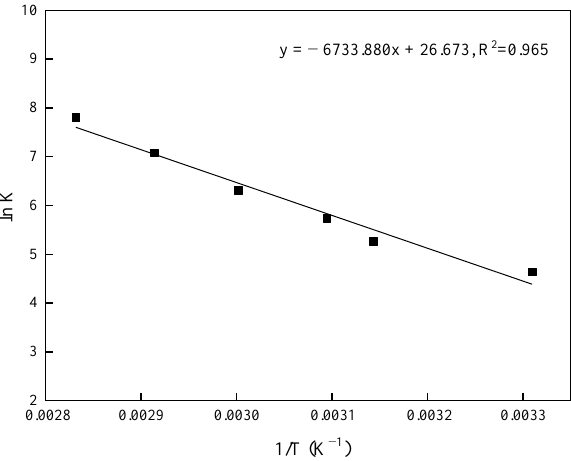
Figure 6. The linear relationship between ln K and 1/T.